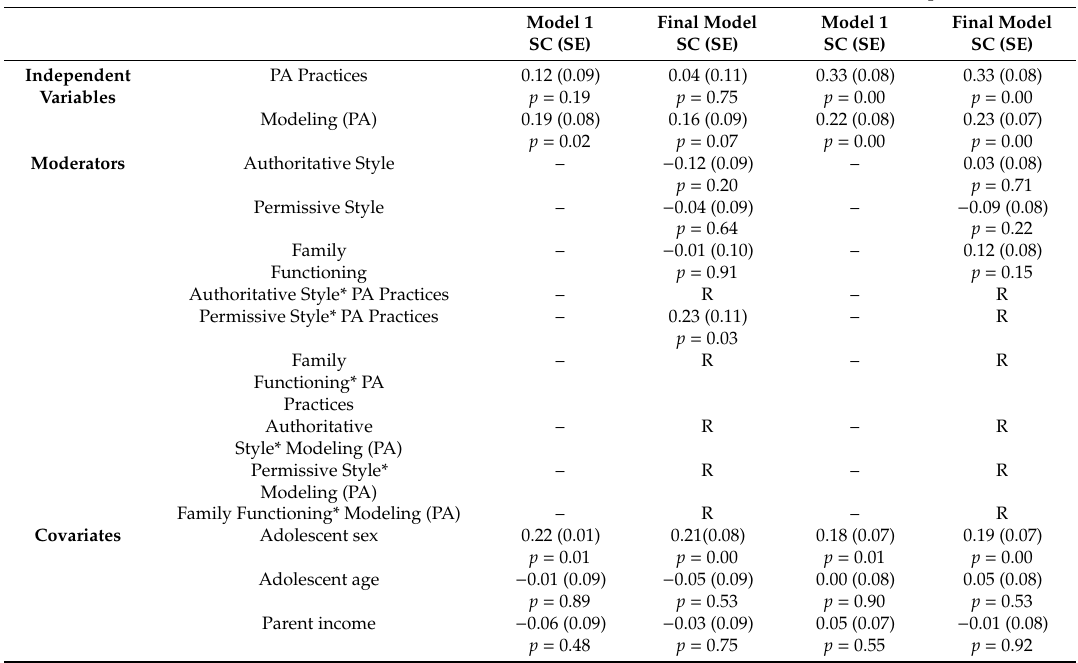
Table 6. Associations between parenting practices and parental modeling of physical activity (PA) on adolescents’ accelerometer and self-report of moderate-vigorous PA